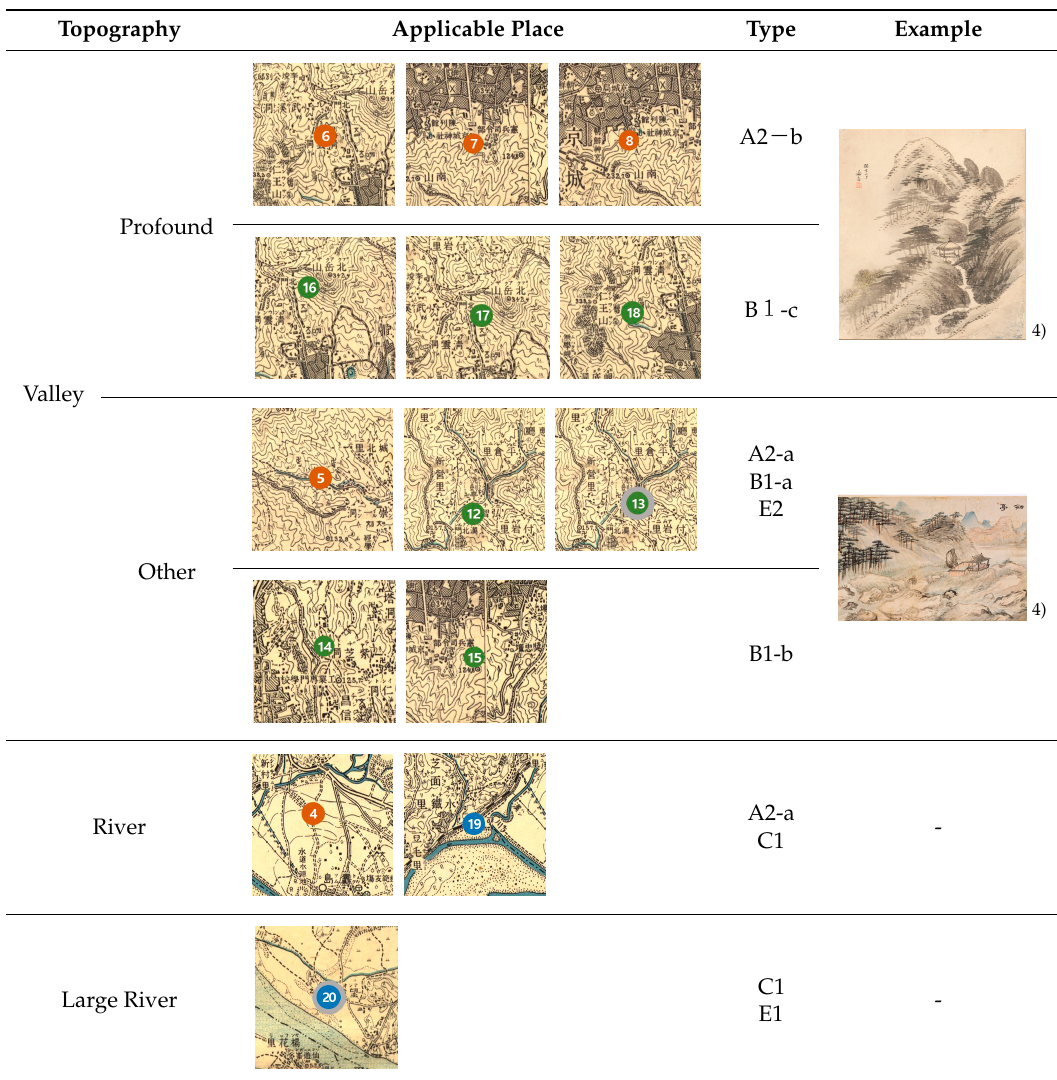
Table 5. Cont. Topography Applicable Place Type